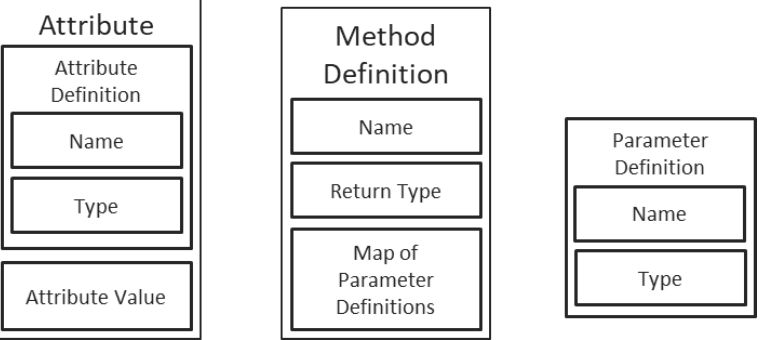
Figure 3. Definitions for attributes, methods and